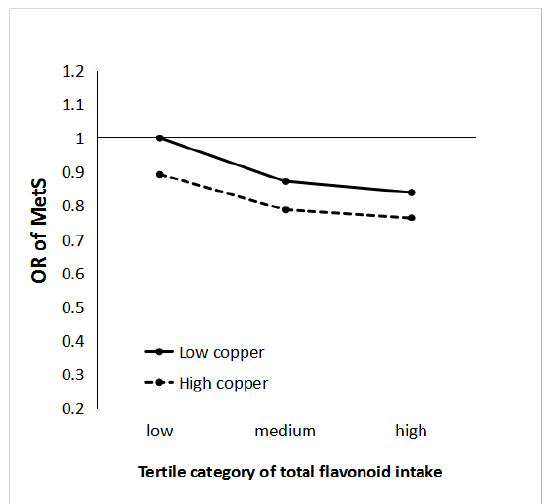
Figure 2. Joint associations of the odds ratio (OR) of flavonoid and copper on the risk of metabolic syndrome (MetS) (P interaction = 0.000). Data represent the OR and 95% confidence intervals of different levels of flavonoid–copper intake adjusted for age, body mass index, sex, drinking, smoking, and physical activity. Tertile-specific point estimates are provided for low, medium, and high flavonoid intakes in tertile categories of low (solid line) and high (dashed line) copper intake.